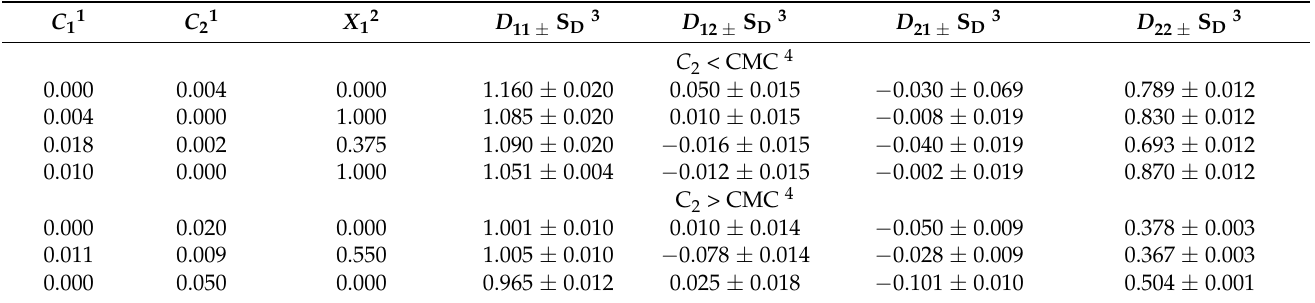
Table 5. Experimental ternary diffusion coefficients ( D 11 , D 12 , D 21 , D 22 ) of 5-FU ( C 1 ) + SDS ( C 2 ) aqueous solutions at T = 298.15 K and P = 101.3